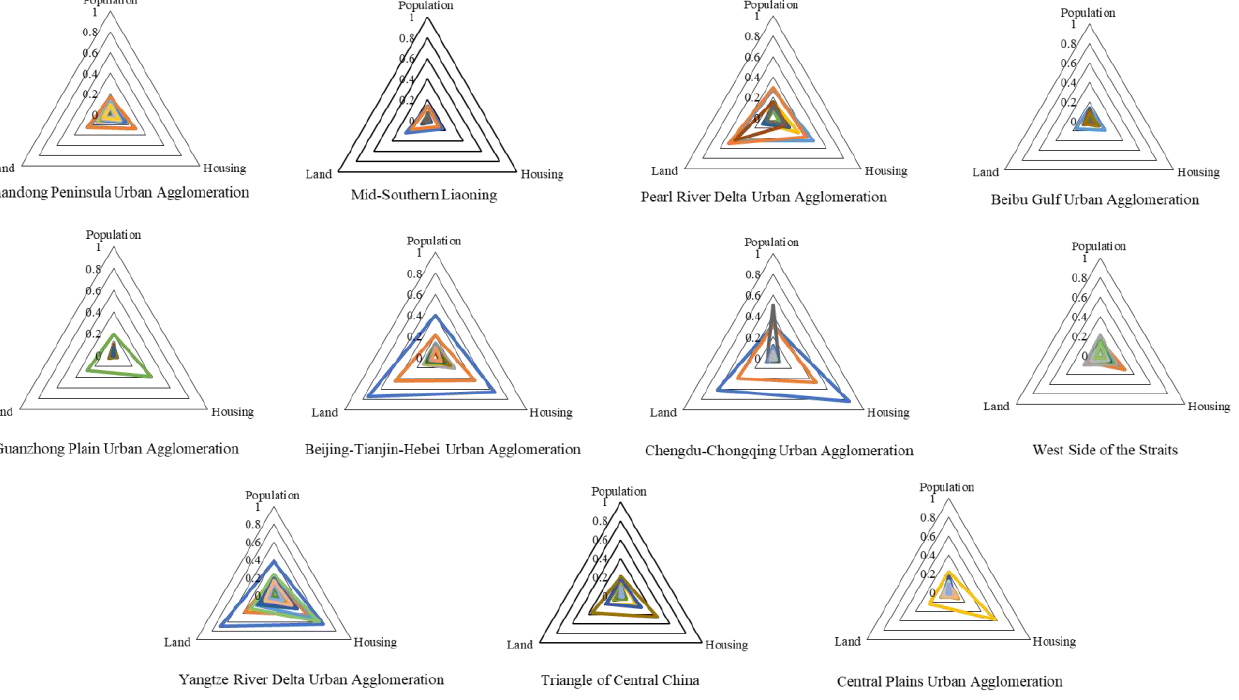
Figure 3. Comprehensive evaluation of 172 cities in 11 urban agglomerations (2017).